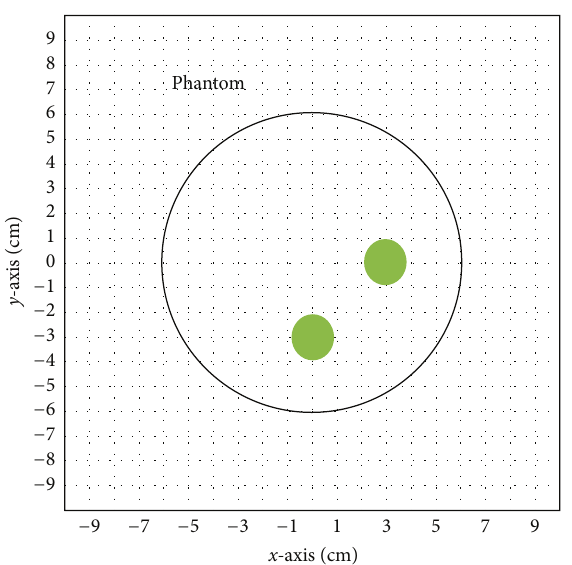
Figure 7: Experiment 1 setup. The fibroglandular structures are denoted in green.